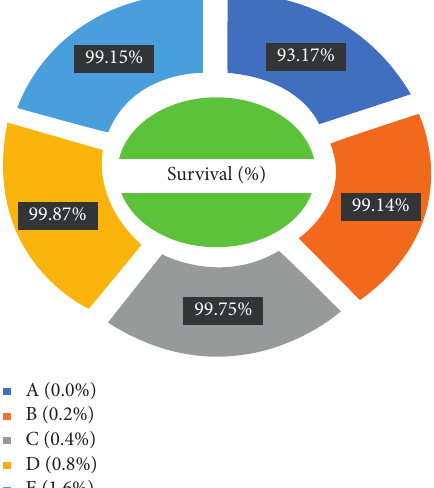
Figure 7: Cyprinus carpio fed varied doses of Aloe vera and survival percentage (S%) studied after 90 days of feeding trial.